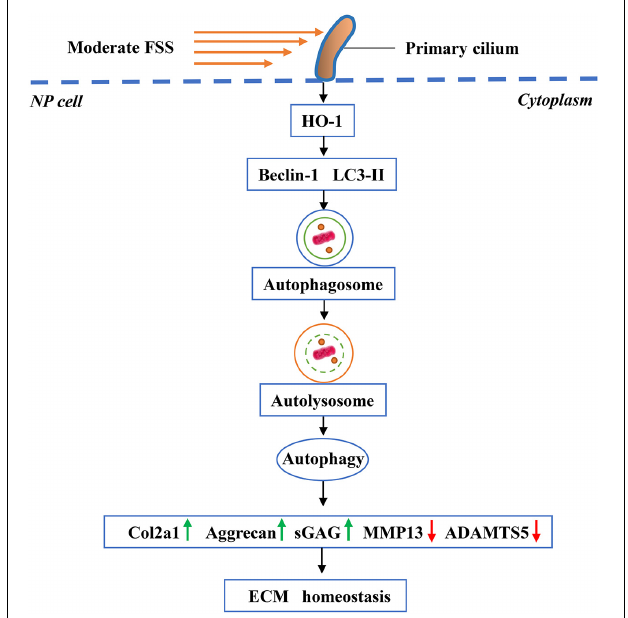
FIGURE 8 | Working model. Primary cilia sense and transmit extracellular FSS signal to NP cells, which activates HO-1 and thereby autophagy. Increased autophagy plays an important role in maintaining ECM homeostasis in NP